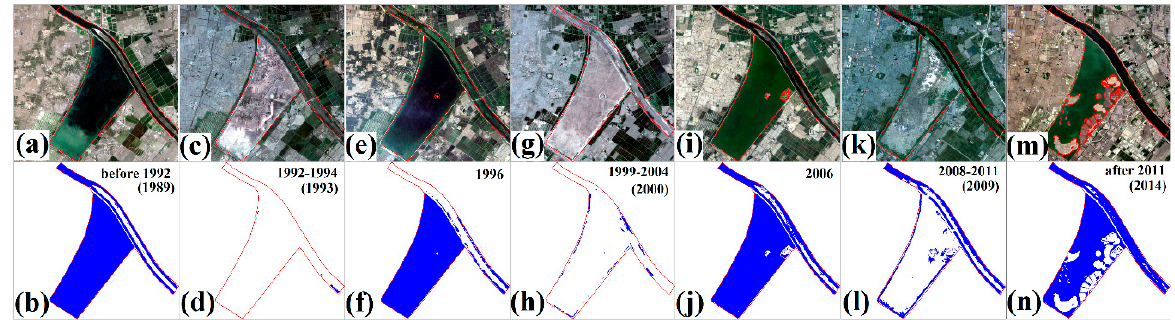
Figure 8. Illustration of land reclamation and images of running out water period in the TBNR from Landsat images of different periods. ( a , c , e , g , i , k , m ) represent true-color Landsat image of TBNR, the corresponding water bodies are shown in ( b , d , f , h , j , l , n ). Note, the years in the brackets represent the image selected year.